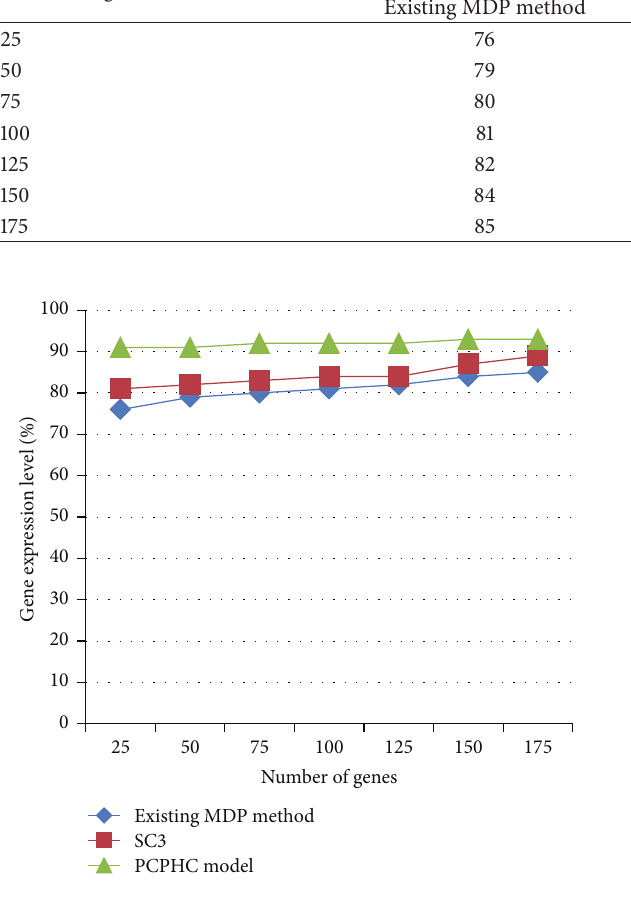
Figure 6: Measure of gene expression level (using yeast gene expression